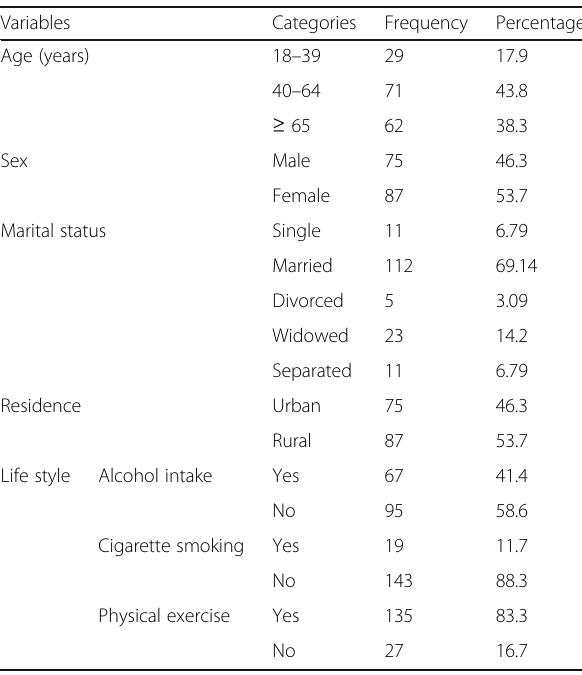
Table 1 Sociodemographic and lifestyle characteristics of stroke patients in Debre Markos Referral Hospital, Northwest Ethiopia,